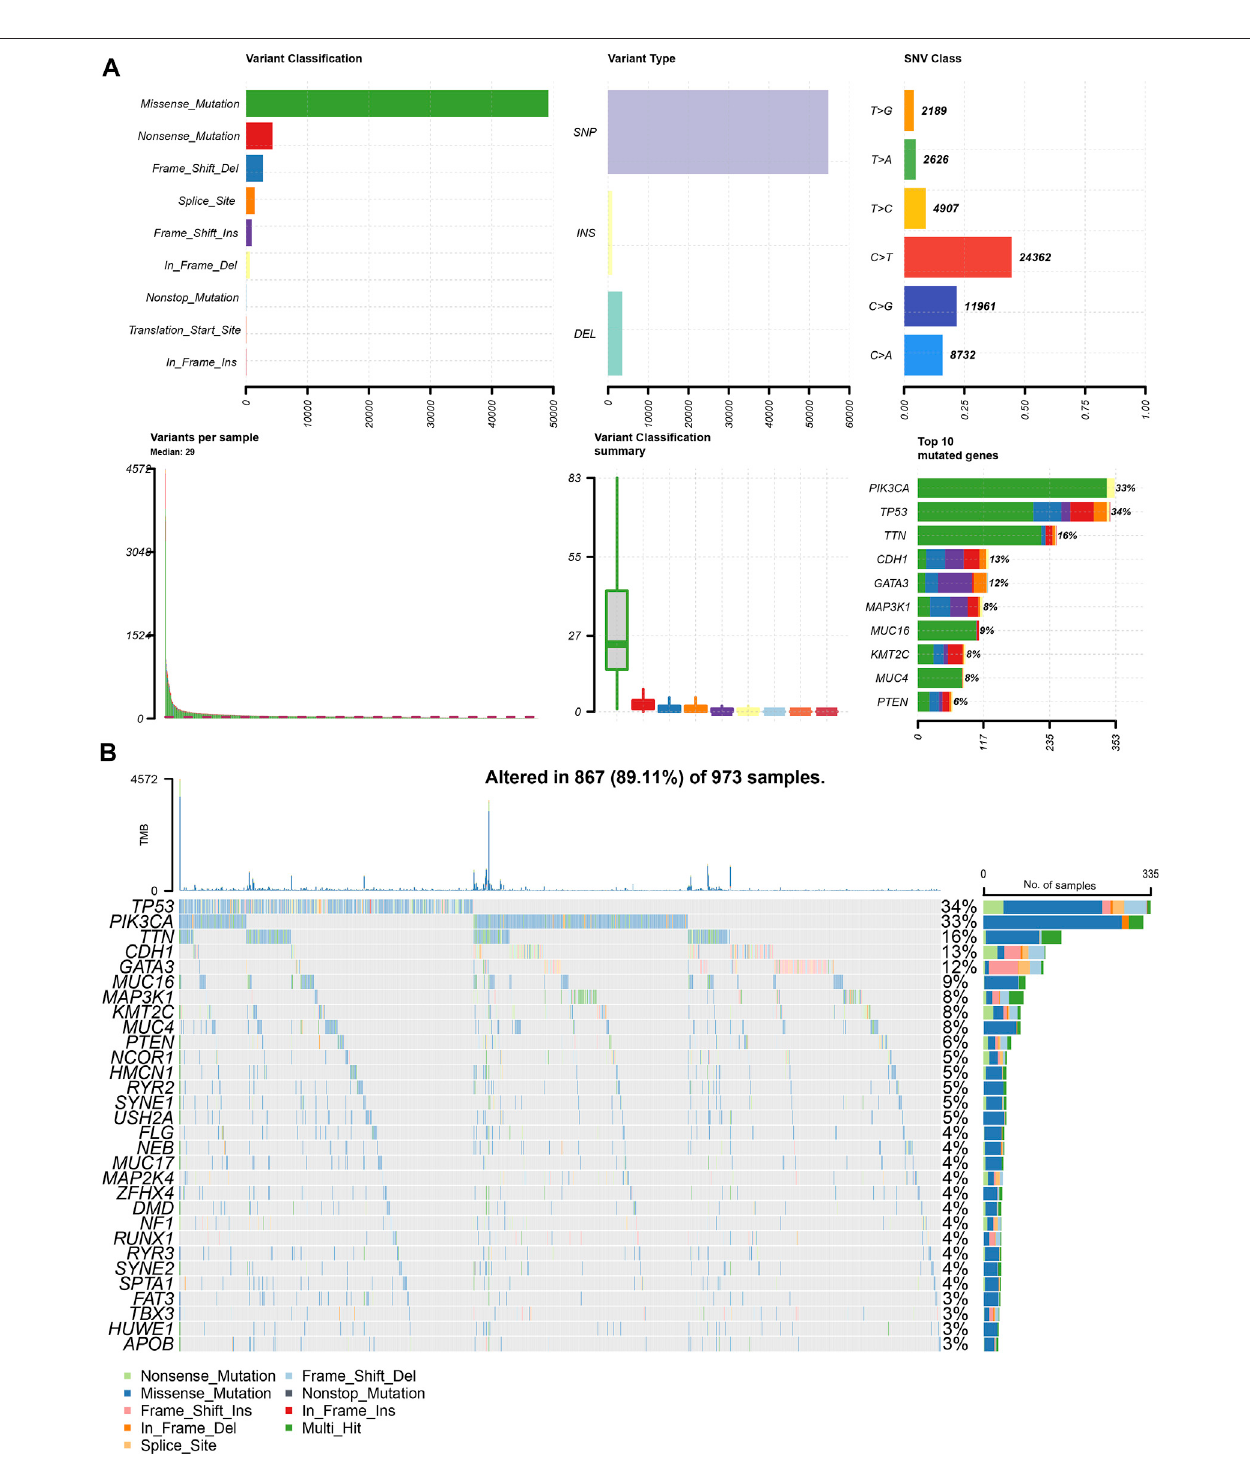
FIGURE 1 | Panoramic view of TCGA-BRCA mutations. (A) Mutation panorama analysis of TCGA-BRCA dataset; (B) Top 30 gene mutation waterfall map of TCGA-BRCA dataset.